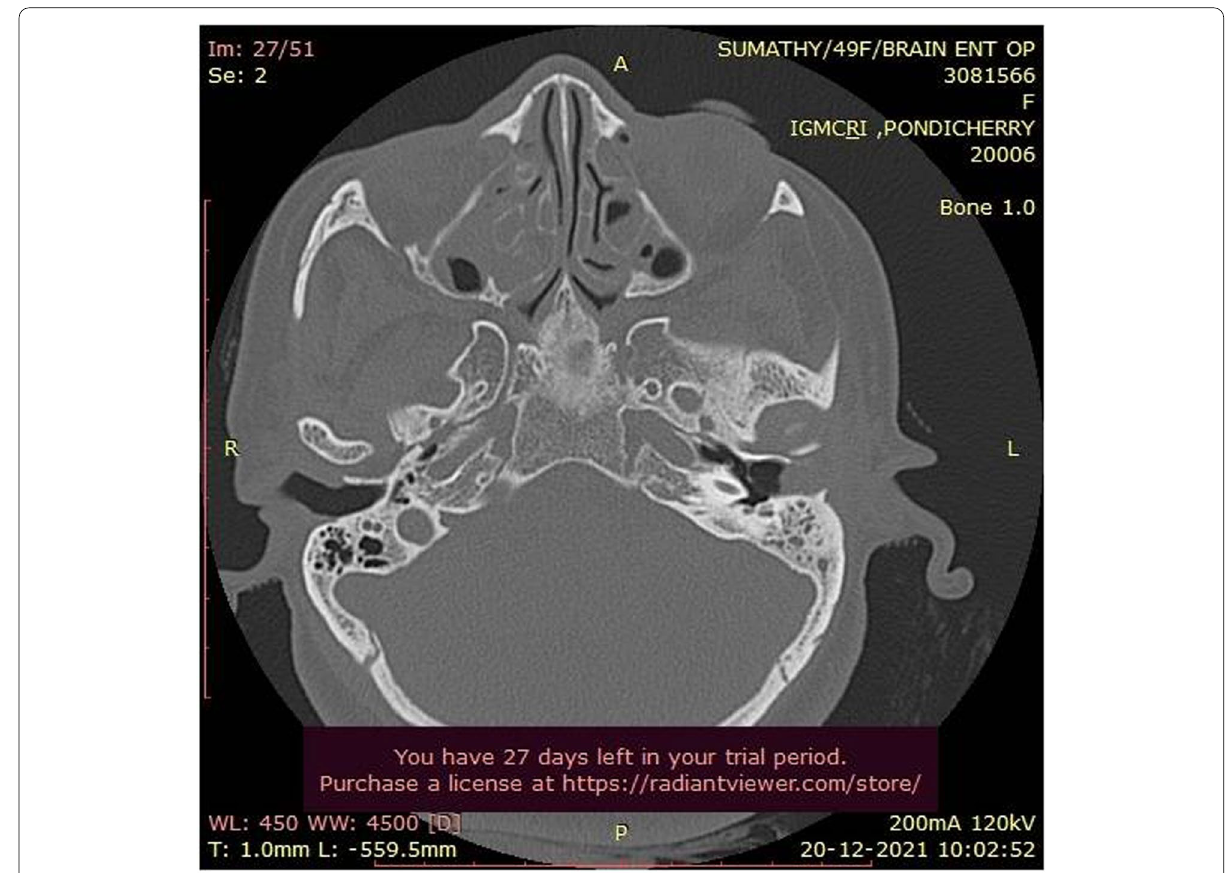
Fig. 2 Soft tissue mass occupying the lateral third of the left EAC, with normal middle and inner ear